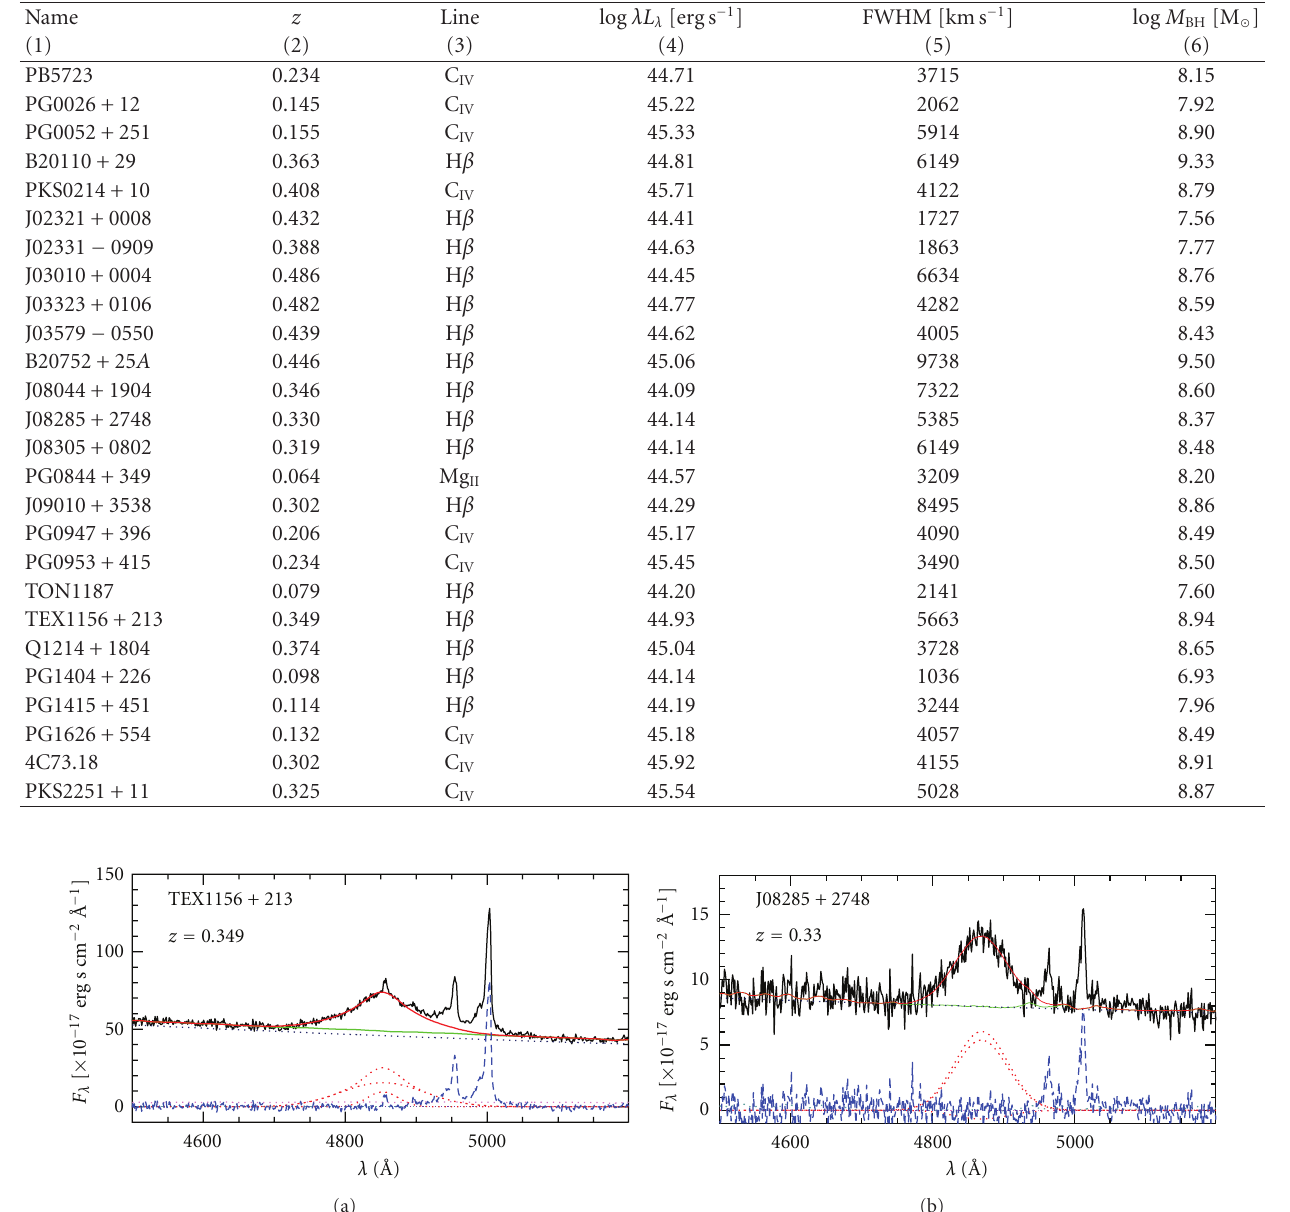
Figure 2: Examples of H β line fitting. The observed spectra, shifted to the rest frame, are plotted in solid, black lines. The various components of the models are shown: the power-law (black, dotted line), the host galaxy and Fe II templates (green, solid line), the line model (red, solid line), and its components (red, dotted lines). Fit residuals are shown in blue, dashed